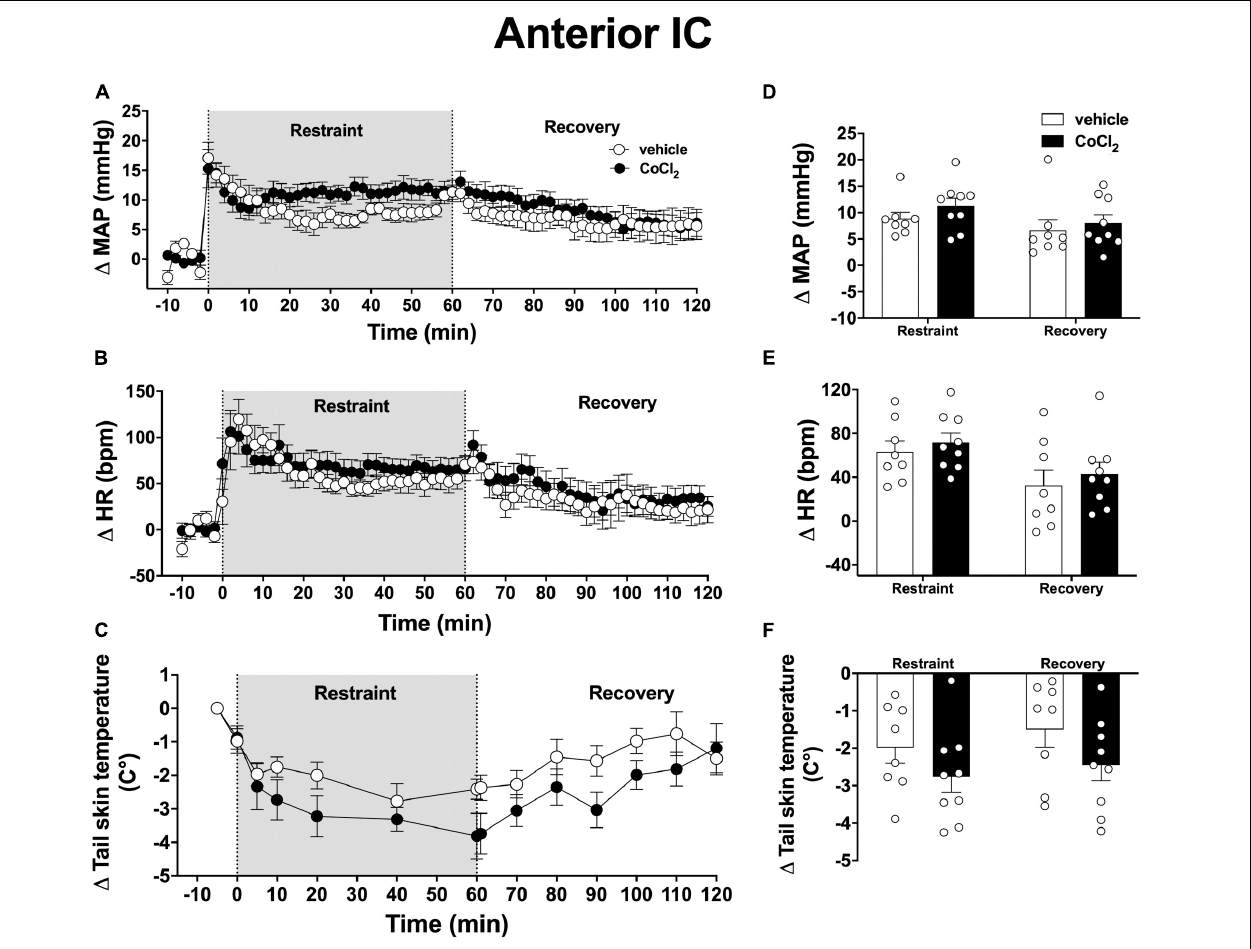
FIGURE 3 | Effect of bilateral microinjection of the non-selective synaptic inhibitor CoCl 2 into the anterior subregion of the insular cortex (IC) on mean arterial pressure (MAP), heart rate (HR), and tail skin temperature responses evoked by an acute 60-min session of restraint stress. (A–C) Time-course curves of changes on MAP ( (cid:49) MAP), HR ( (cid:49) HR), and tail skin temperature ( (cid:49) tail skin temperature) evoked by acute restraint stress in animals treated bilaterally into the anterior subregion of the IC with vehicle (saline, 100 nl, n = 8) or the non-selective synaptic inhibitor CoCl 2 (1 mM/100 nl, n = 9). Shaded area indicates the restraint stress period. Circles represent the mean ± SEM. Two-way ANOVA. (D–F) Mean of (cid:49) MAP, (cid:49) HR, and (cid:49) tail skin temperature during the restraint and recovery periods in animals treated bilaterally into the anterior IC with vehicle ( n = 8) or CoCl 2 ( n = 9). Bars represent the mean ± SEM. Two-way